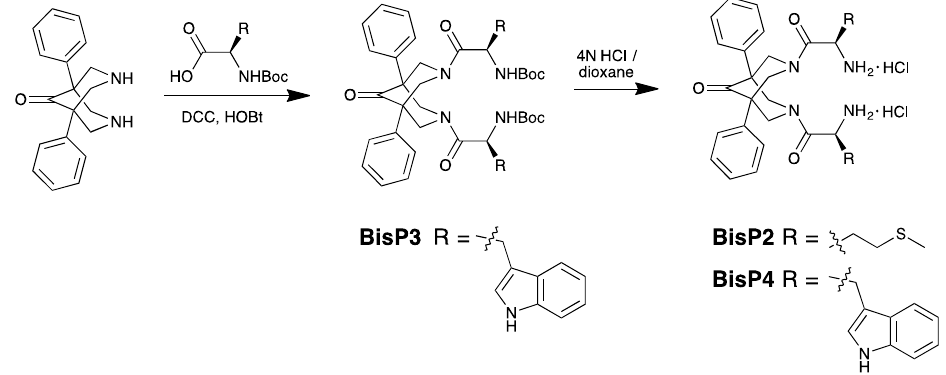
Table 1. Structures of four bispidinone derivatives and their effect on pancreatic cancer cell viability. Significantly Reduced Cell Bispidinones